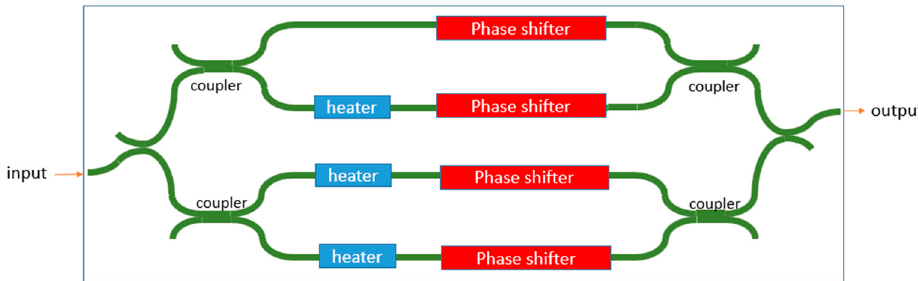
Figure 10. Schematic diagram of a single-sideband suppressed-carrier (SSB-SC) modulator to generate an optical frequency shift used for PIC-based heterodyne LDV systems.